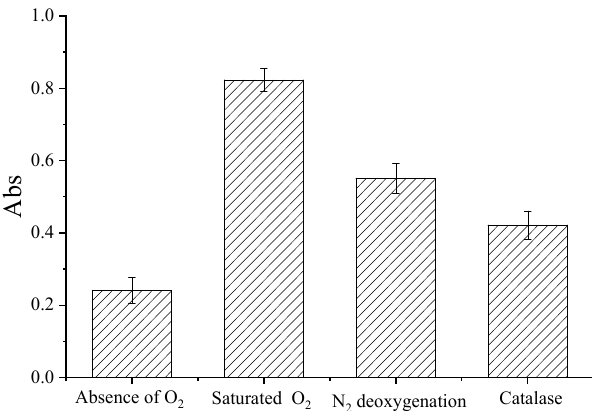
Figure 1. The catalytic reaction in the presence or absence of oxygen.